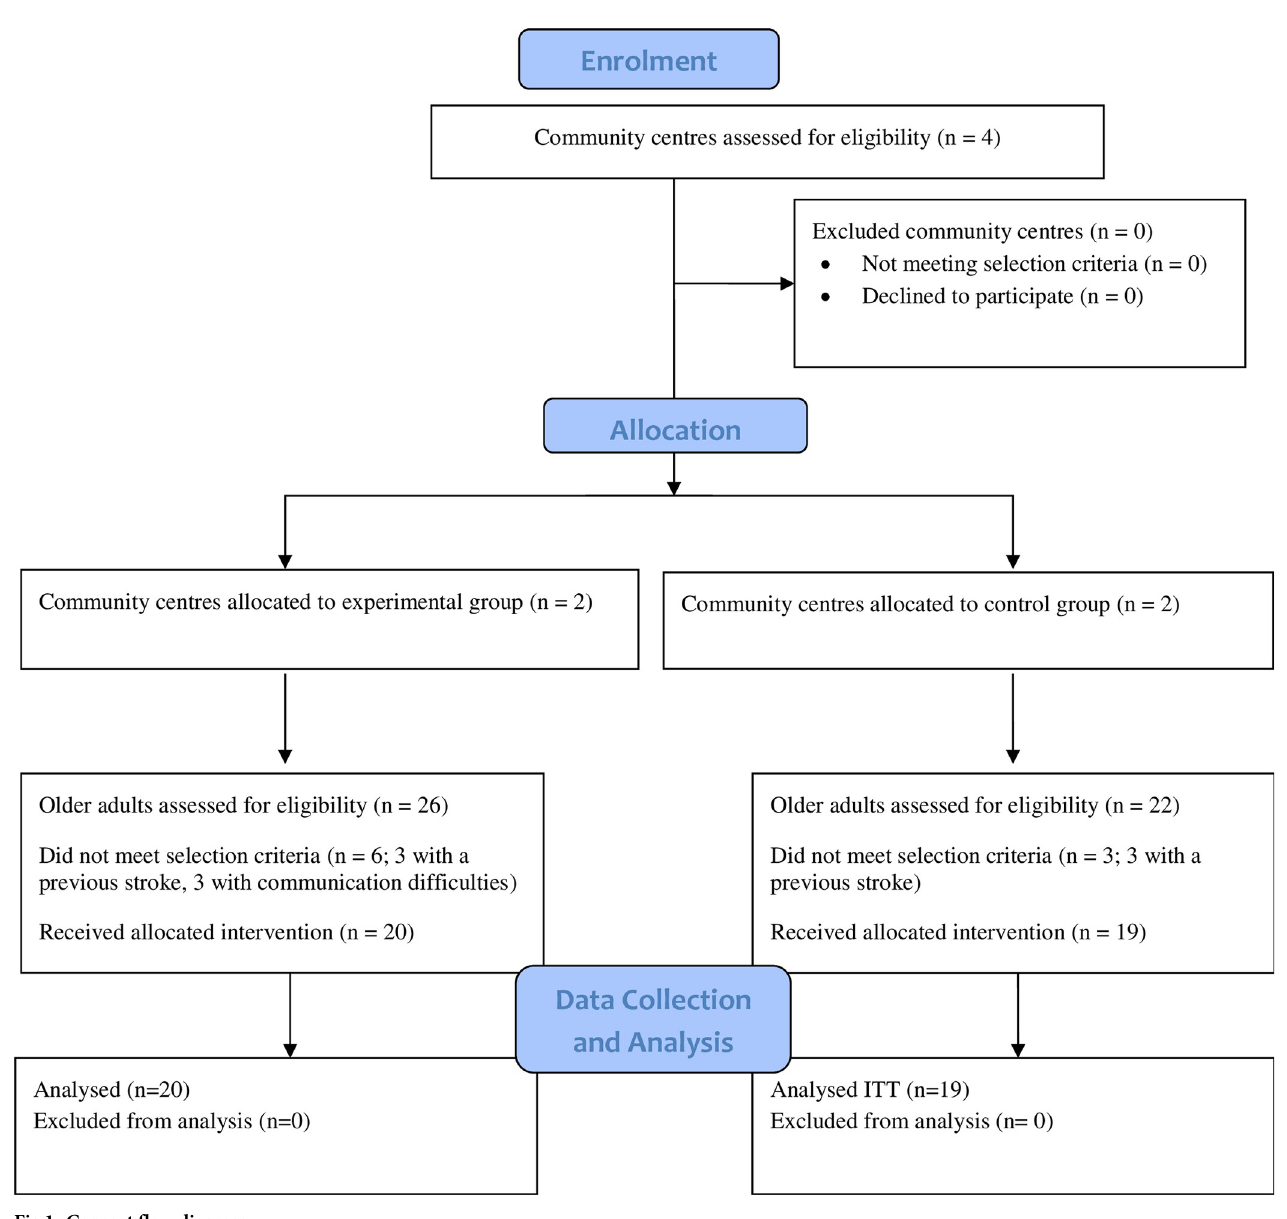
Fig 1. Consort flow